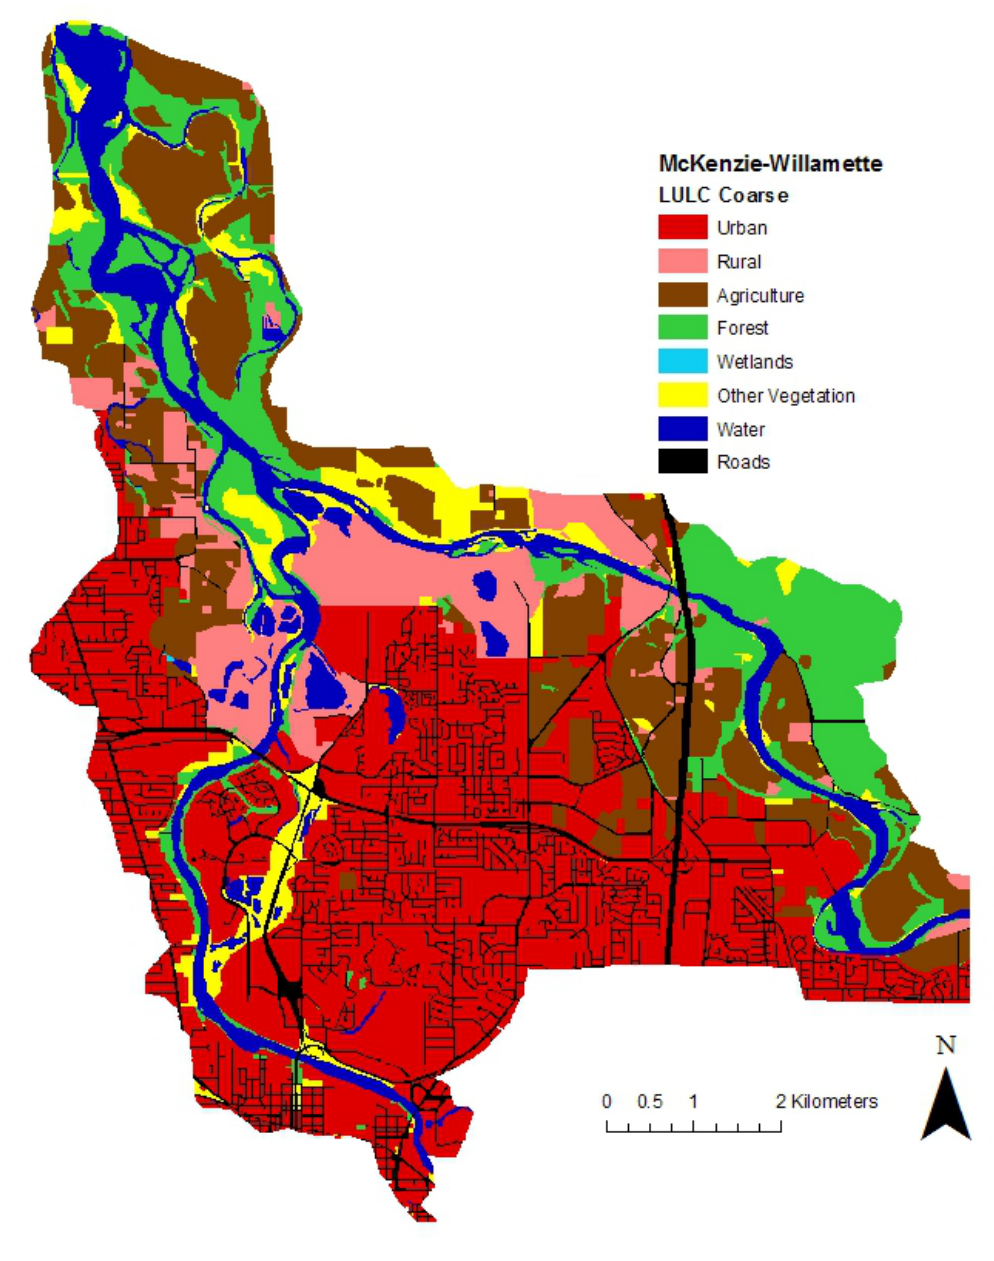
Fig. 5 . Initial coarsest articulation of nine land-use and land-cover (LULC) classes in the McKenzie- Willamette study area. This was the distribution of LULC classes in 2000. The Willamette River flows from south to north through the study area. The McKenzie joins the Willamette from the